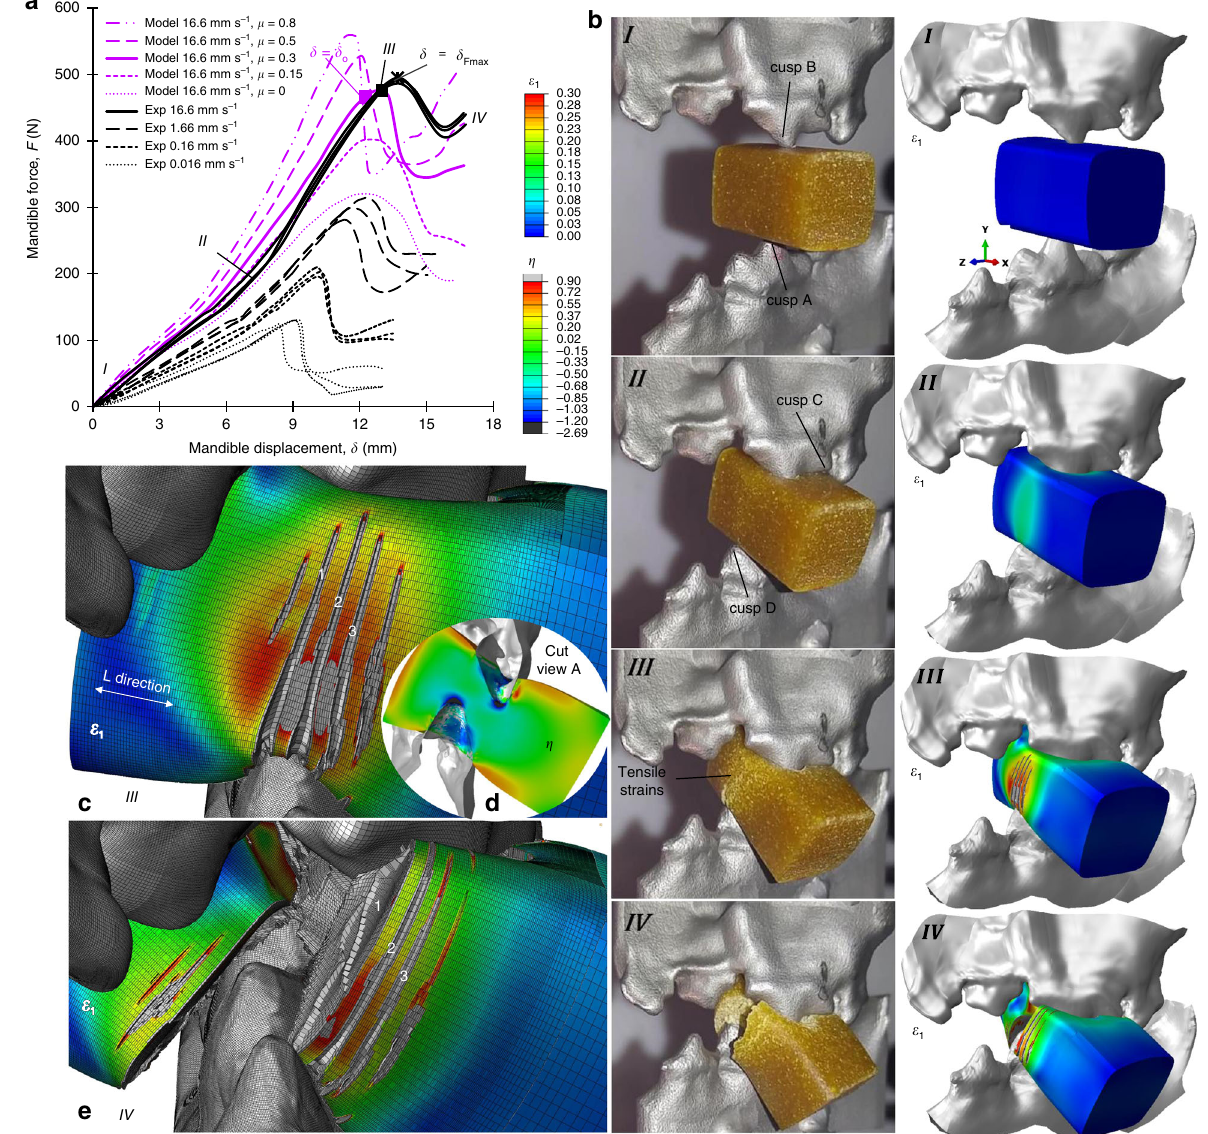
Fig. 4 Summary of mastication experimental-FE model predictions. a shows raw experimental force-displacement data for the four mandible speeds together with predictions for the speed 16.6 mm s − 1 as a function of fi ve friction coef fi cients; experiments are performed in an Instron 5543 universal testing machine with load cell capacity of 1 kN, whereas simulations are performed via ABAQUS-Explicit 39 . b shows qualitative experimental-model comparison for the speed 16.6 mm s − 1 and friction coef fi cient 0.3, through video frames of maximum principal strain contours corresponding to the four stages, I – IV, denoted in a . c illustrates maximum principal strain contours through side view of the food at the onset of breakdown – stage III; initial element deletions due to G c = 0 kJ m − 2 mark mainly three potential crack paths, denoted as 1, 2 and 3. d displays stress triaxiality contours via cut view B (de fi ned in Fig. 4d) at stage III. e shows progressed stage of panel c at maximum mandible displacement (stage IV); note that only crack 1